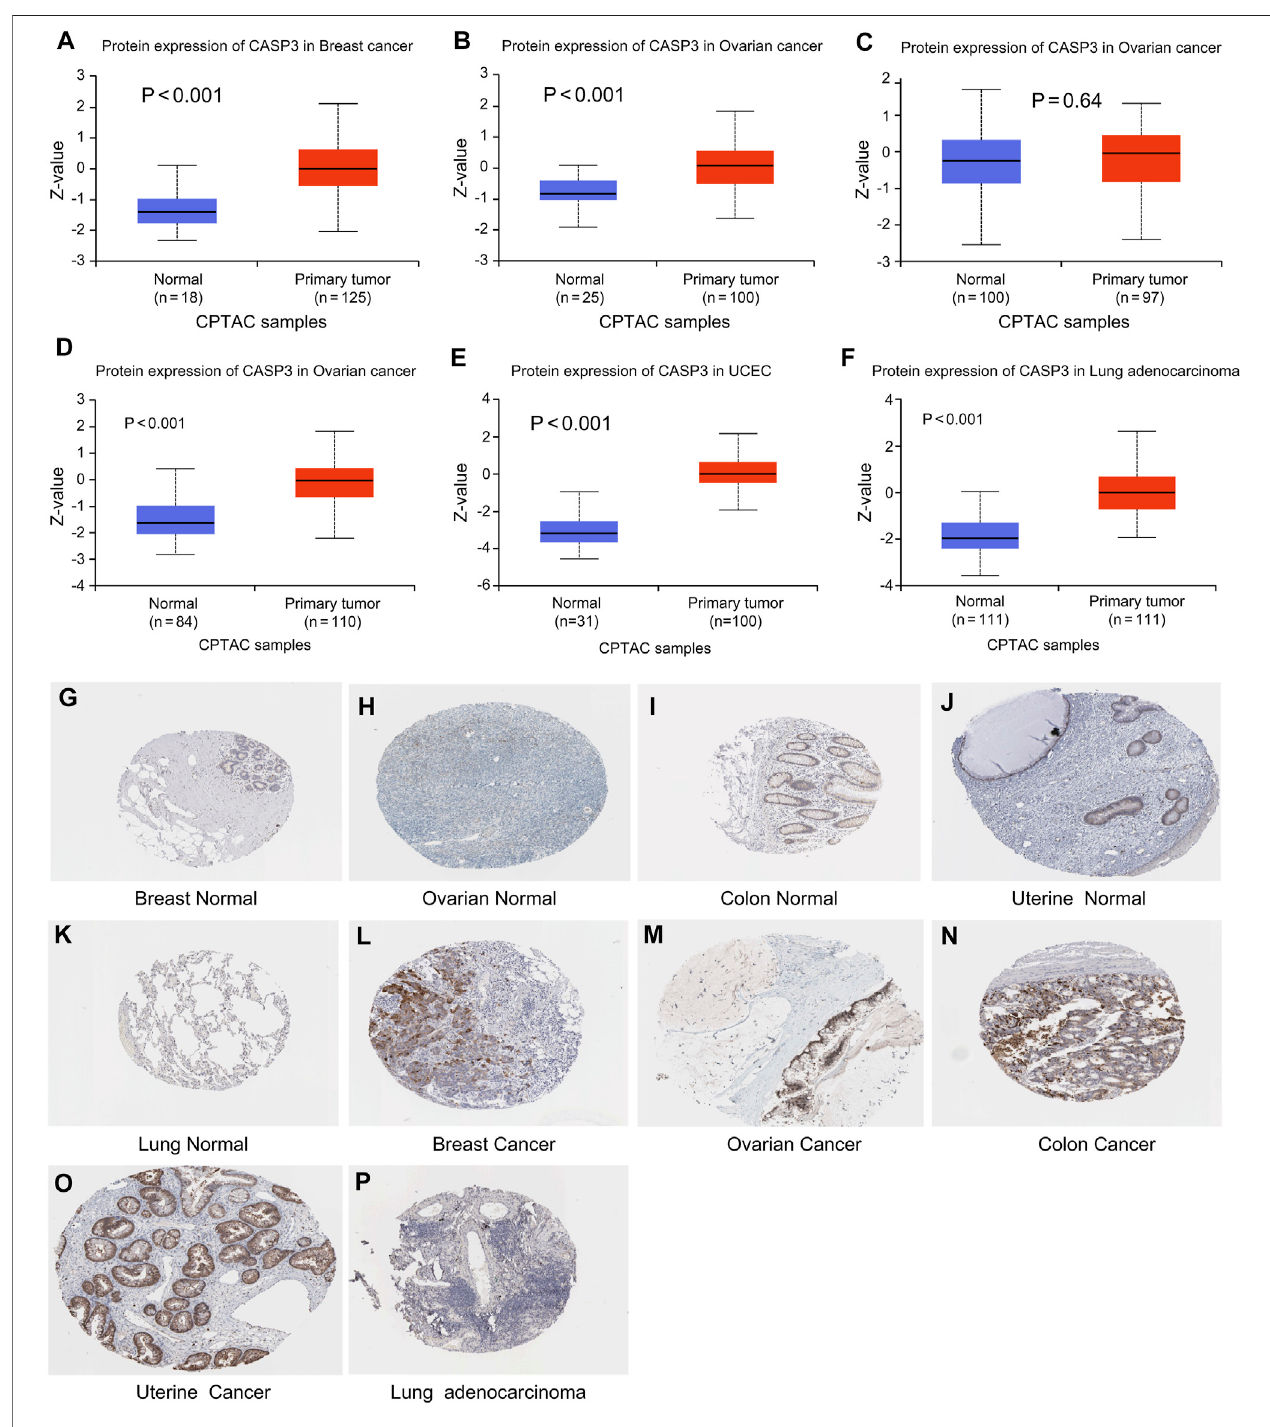
FIGURE 2 | Levels of CASP3 in different tumours. Results based on CTPAC and HPA database (A – F) CASP3 is differentially expressed in breast cancer, ovarian cancer, colon cancer, clear cell RCC (renal cell carcinoma), UCEC and LUAD in tumour tissues and normal tissues in CTPAC database. (G – P) Expression of CASP3 in breast, ovarian, uterine and lung tissues was much higher than that in normal